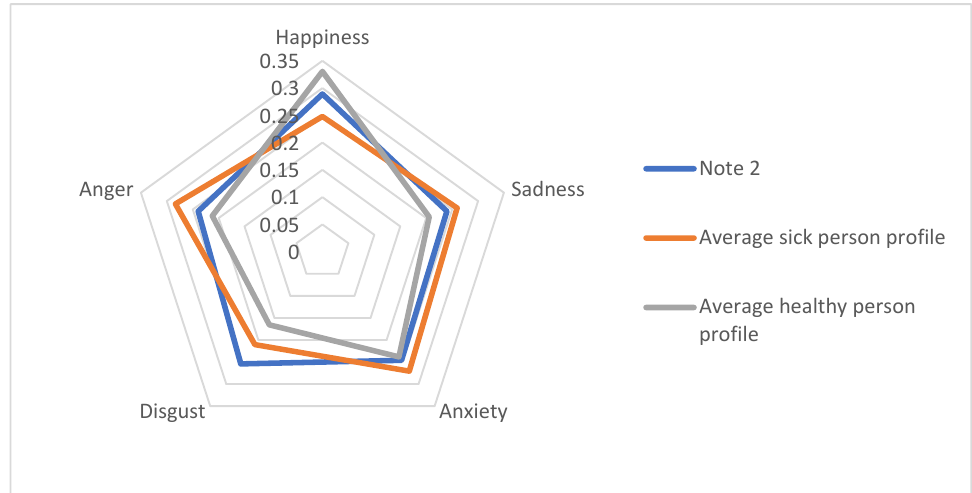
Figure 8. Comparison of the intensity of emotions present in the second note with the profiles of a healthy person and a person suffering from anorexia nervosa (the values of the intensity of emotions range from 0 to 1, where 0 means that there is no emotion in the note, and 1 the maximum value of emotion in the note).